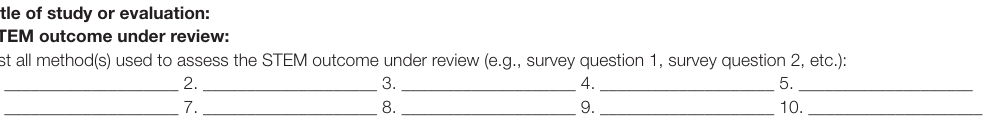
TABLE 3 | STEM impact rubric for quantitative studies. Title of study or evaluation: STEM outcome under review: